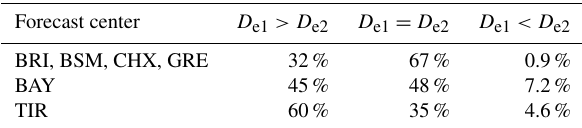
Table 4. Elevational differences in danger rating with D e1 , the dan- ger level above an indicated level, and D e2 , the danger rating below this elevation level. Example distributions are provided for some forecast centers.